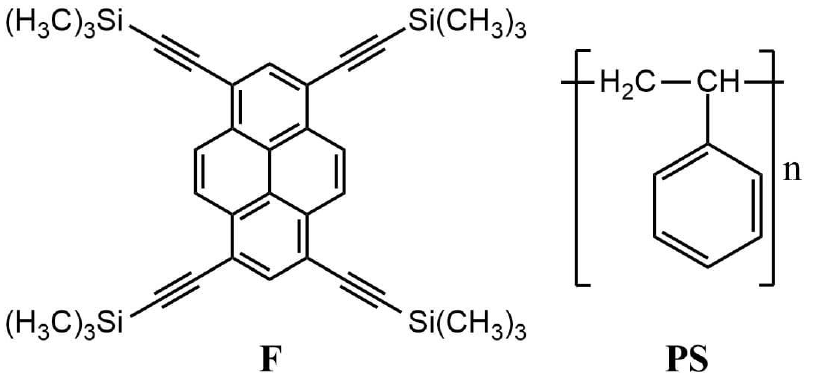
Figure 1. Structures of fluorophore F and polystyrene (PS) used to prepare fluorescent sensing ma- terials.